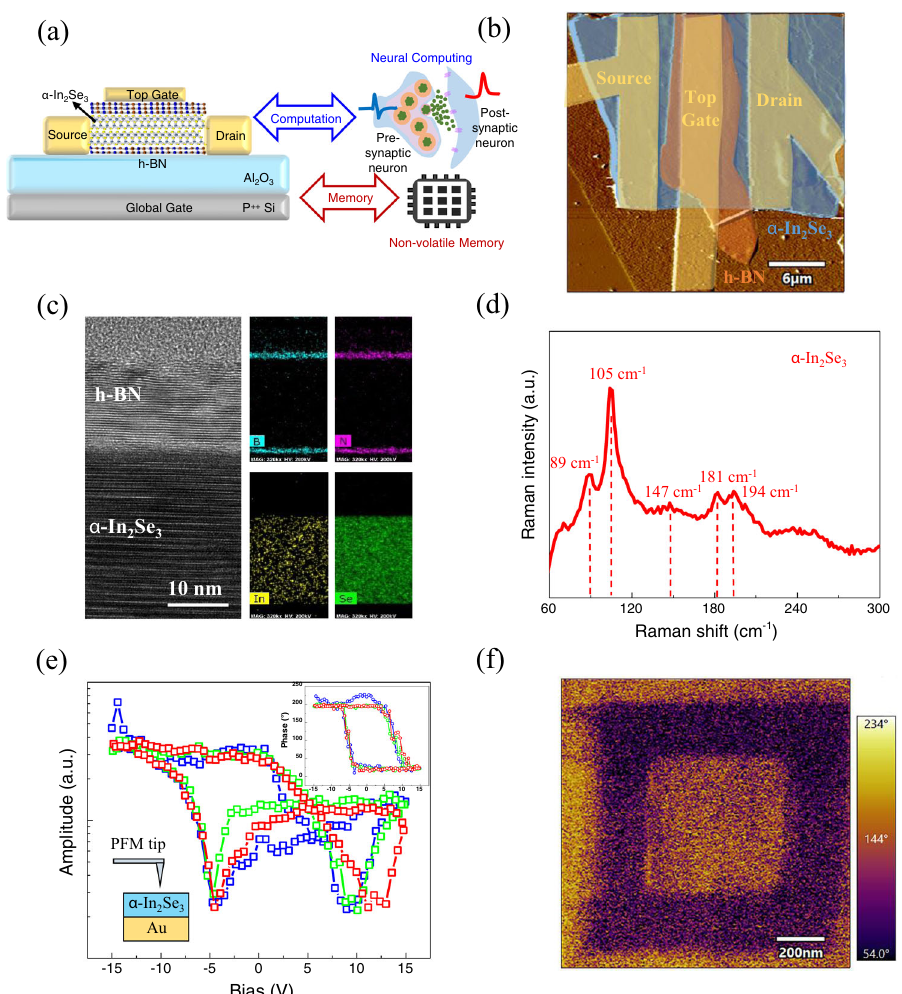
Fig. 1 Schematic and characterization of 2D α -In 2 Se 3 FeCTs for memory and computing. a The 2D FeCTs structure integrates memory and computing functions, in which α -In 2 Se 3 ferroelectrics serve as channel layer, Al 2 O 3 and hBN as the global and top dielectric layers respectively. Non-volatile memory is implemented by GG, and neural computing is realized simultaneously with combination of TG. b False color AFM amplitude error image of the 2D FeCTs. Sacle bar: 6 μ m. c High-resolution STEM image of multilayer h-BN and α -In 2 Se 3 heterojunction and corresponding EDS element mapping in FeCTs, which indicates a clean interface. Sacle bar: 10 nm. d Raman characterization of α -In 2 Se 3 , where the 89 cm − 1 peak position suggests a hexagonal structure. e The three-cycle off- fi eld PFM amplitude hysteresis loop of the channel α -In 2 Se 3 , the illustration includes the test structure and the PFM phase hysteresis loop, which shows a clear ferroelectric polarization fl ip. f The phase image after writing the outer rectangular track and inner square by applying + 8 V and − 8 V bias to the α -In 2 Se 3 through PFM. Sacle bar: 200